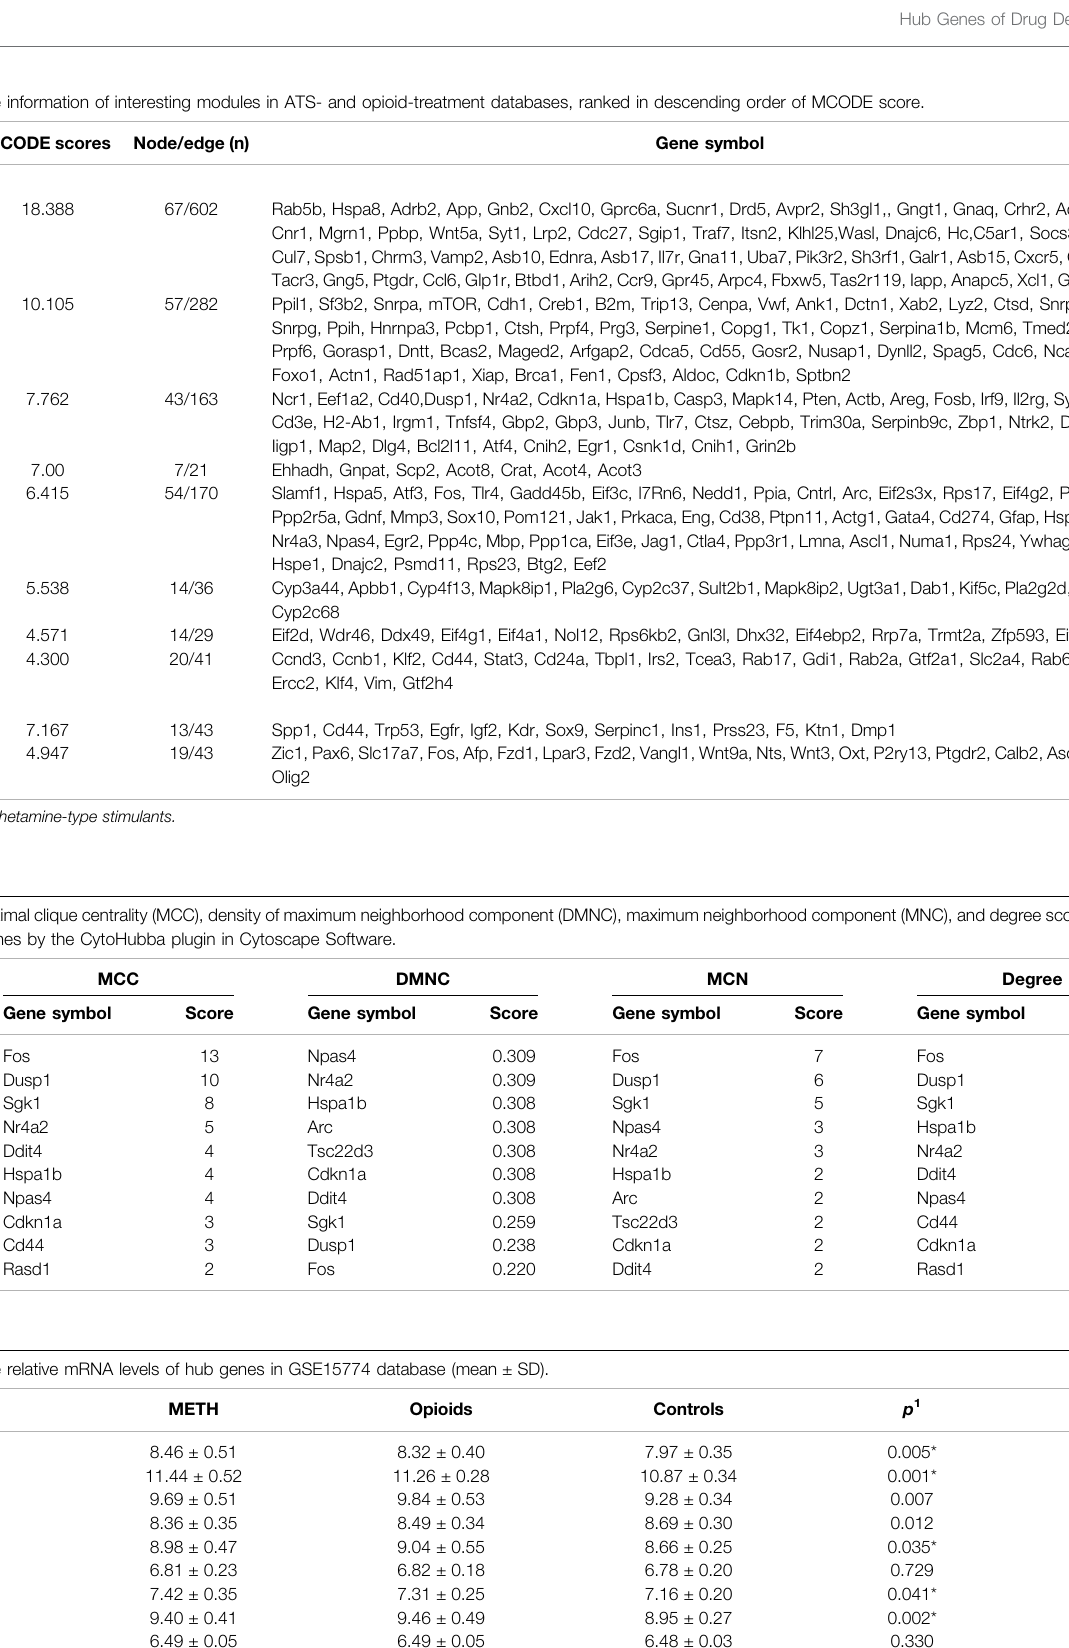
TABLE 3 | The information of interesting modules in ATS- and opioid-treatment databases, ranked in descending order of MCODE score. Category MCODE scores Node/edge (n)